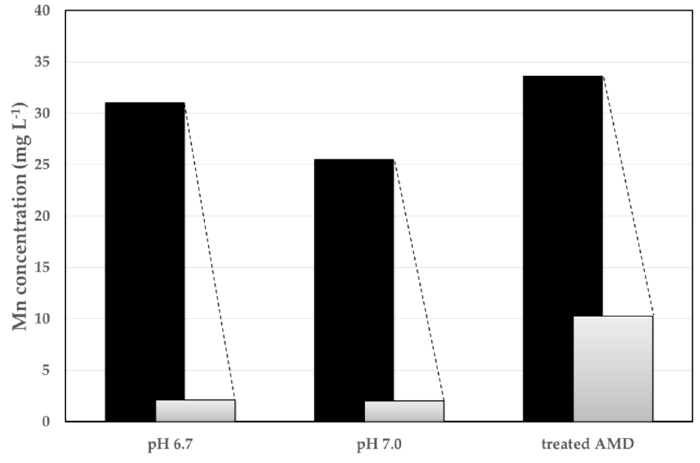
Figure 7. Change in Mn concentration before and after the adsorption removal test using 5 g of chitosan.